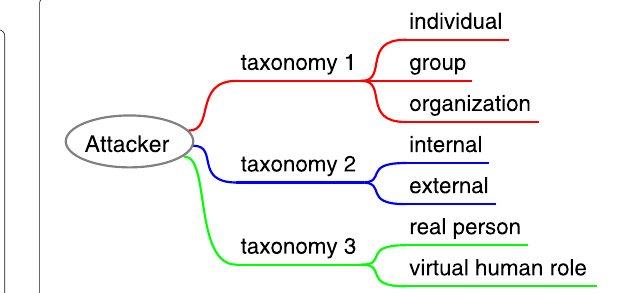
Fig. 5 Core entities (concepts) in social engineering domain Fig. 6 Taxonomy of attacker (social